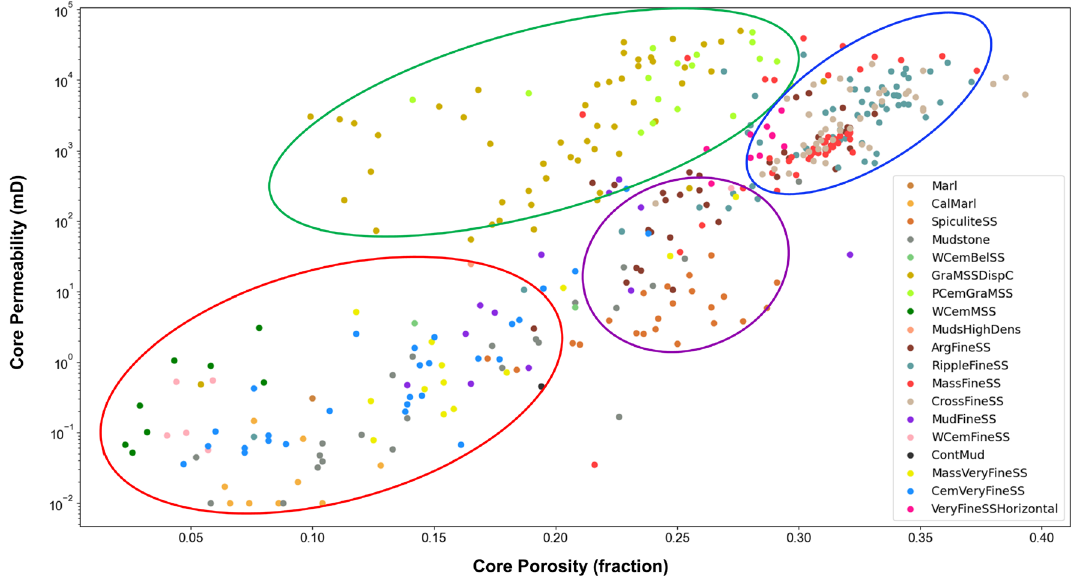
cies exhibit similar porosity–permeability relationship marked by ellipsoids with different